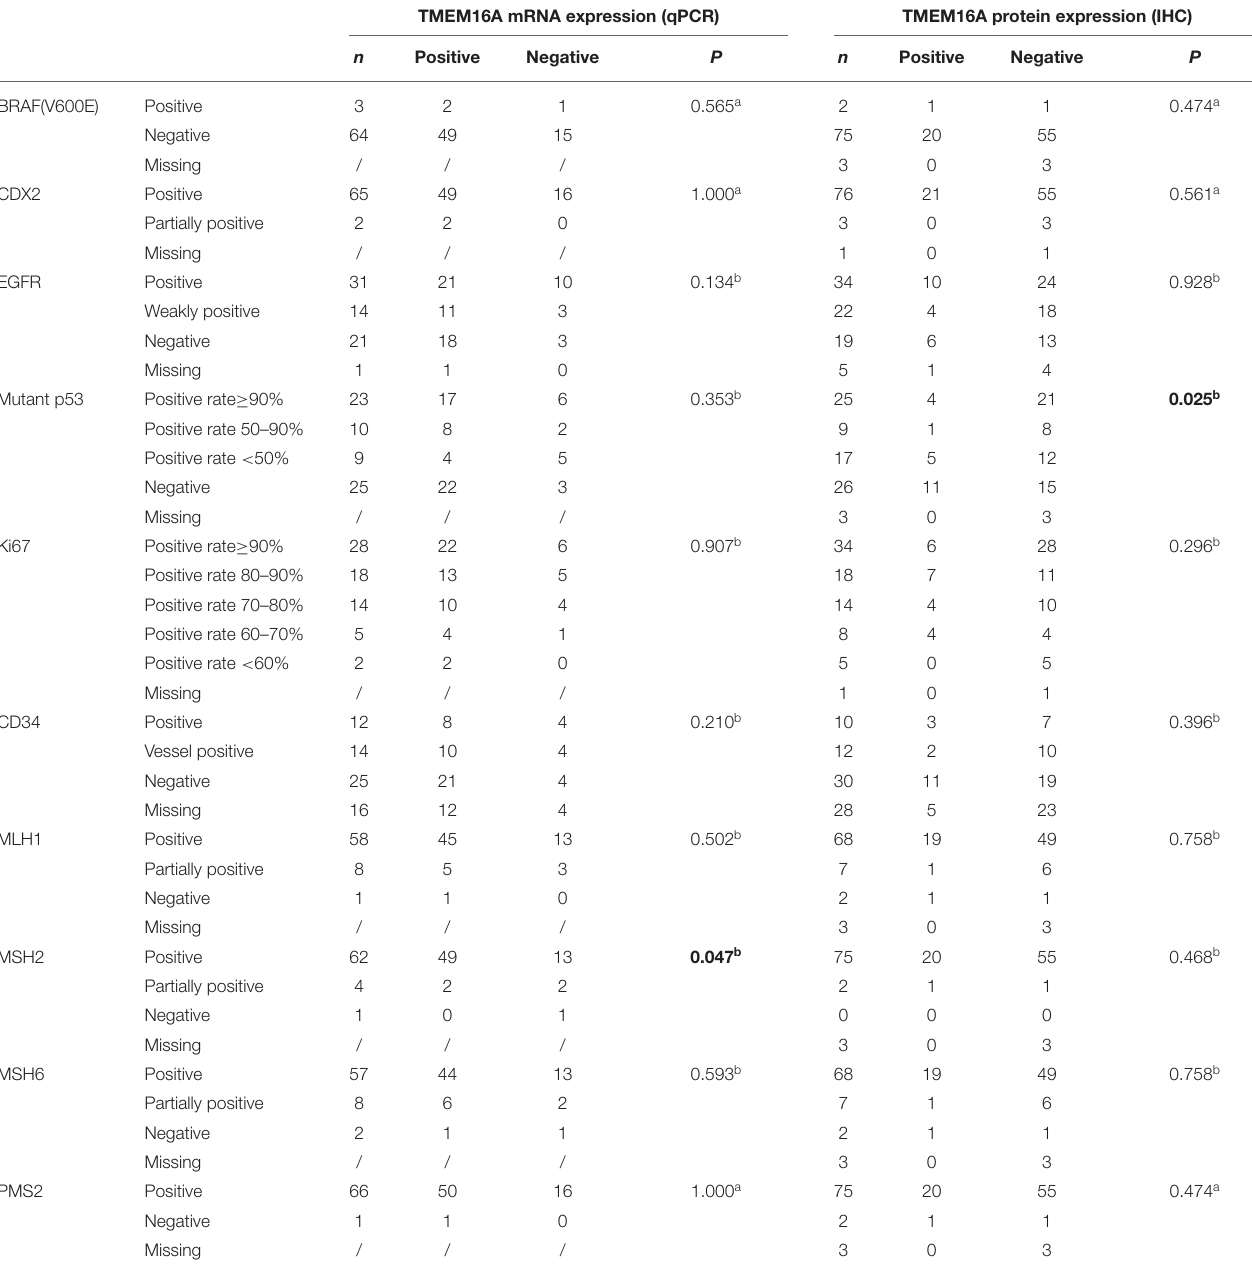
TABLE 4 | TMEM16A mRNA and protein expression in relation to immunohistochemistry characteristics in